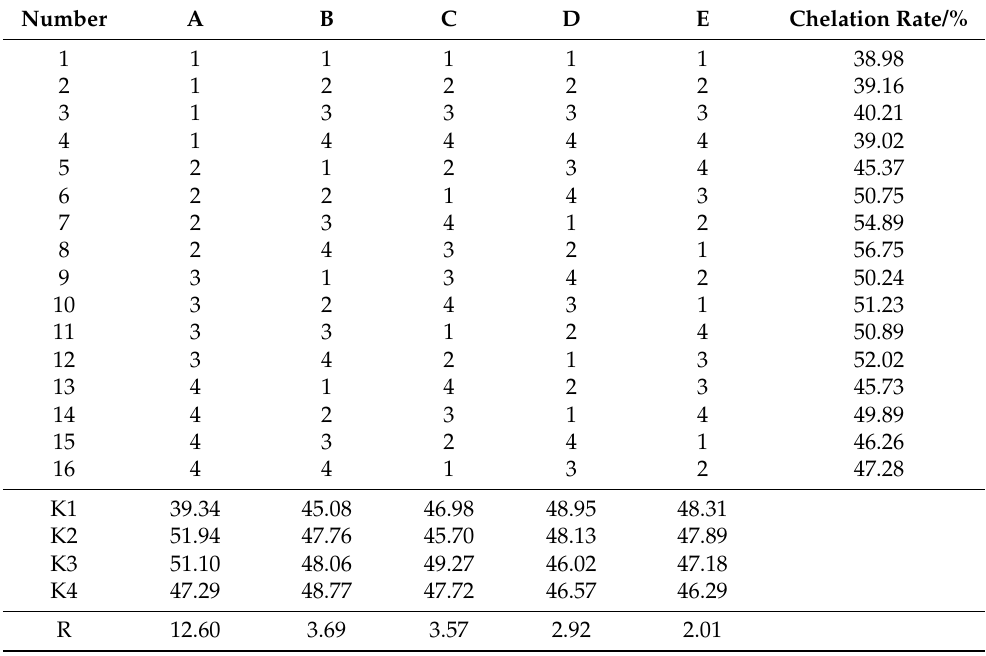
Table 2. Orthogonal test (L 16 (4 5 )) of Gly − chelated Se production